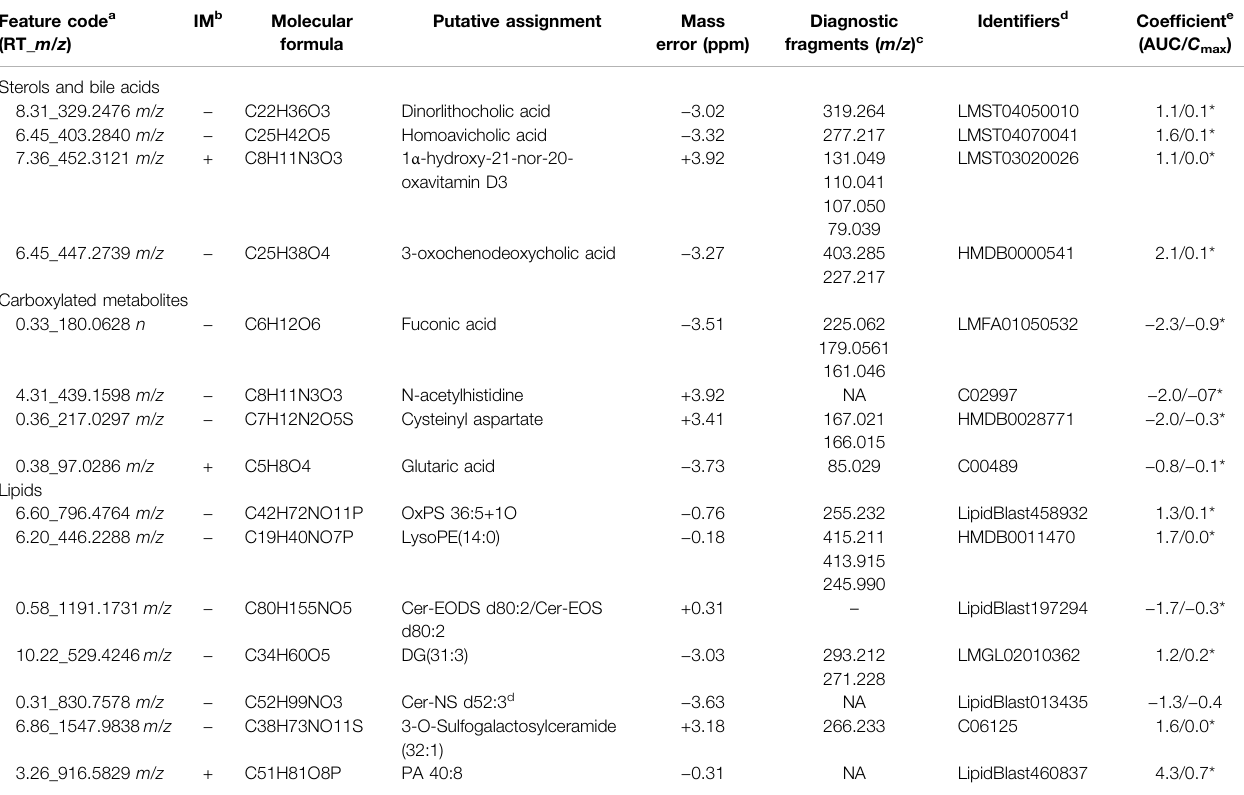
TABLE 3 | Most relevant and putatively identi fi ed metabolites selected by the Elastic Net regression model for pharmacokinetic parameters prediction. Feature code